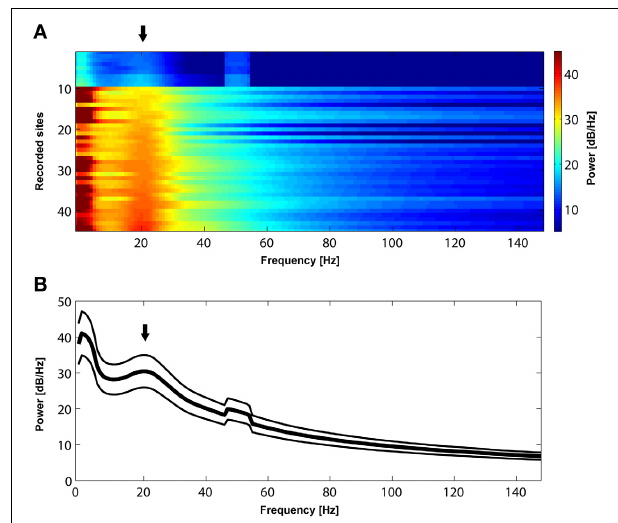
FIGURE 2 | (A) Power spectrum of resting-state activity in 45 recorded sites sorted according to the power magnitude at 22Hz. All sites exhibit a prominent peak (black arrow) in the beta frequency range (approximately between 15 and 30Hz). (B) . Mean power spectrum ± s.e.m during resting state activity across the 45 recorded sites presented in (A) . Note a bump (black arrow) in the mean power spectrum in the beta range. The peak in 50Hz is due to power line